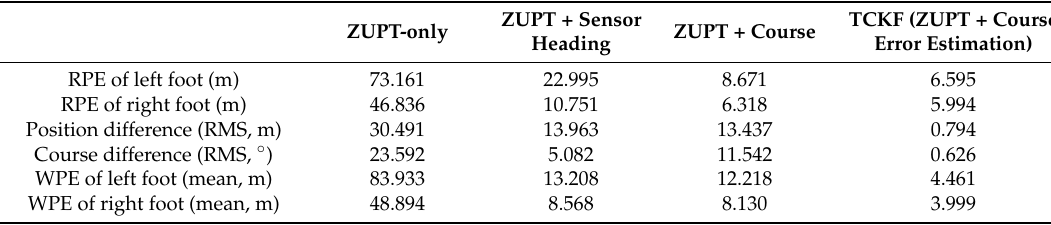
Table 2. Summary of experimental